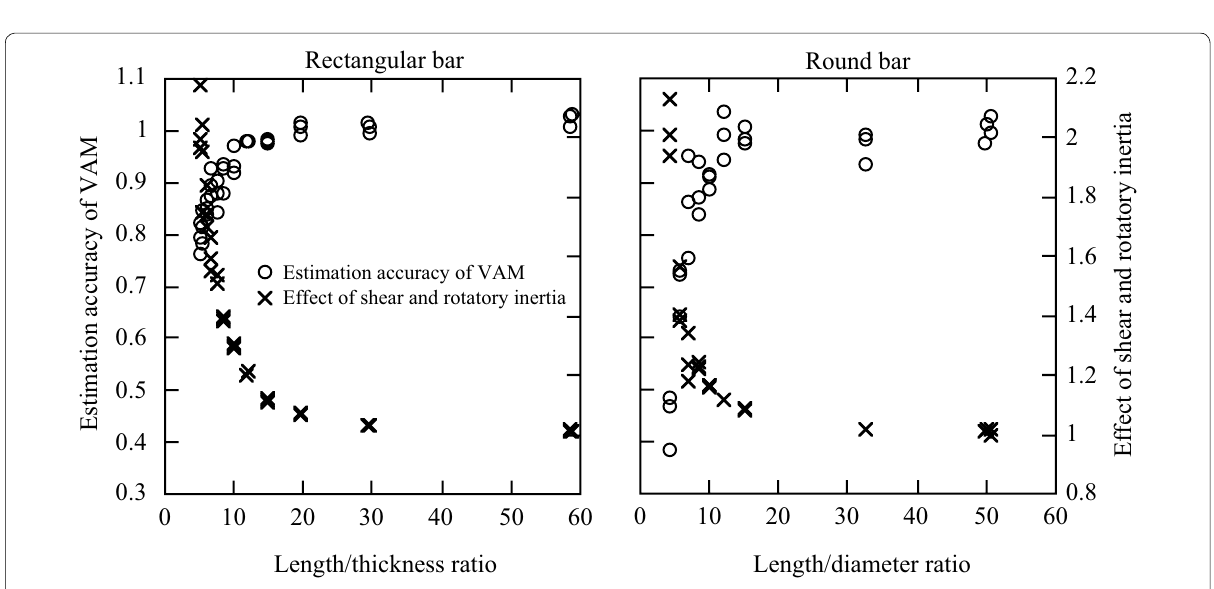
Fig. 3 Estimation accuracy of the VAM and the effect of deflections due to shear and rotatory inertia involved in the bending vibrational deflection (SR effect) at various length/thickness and length/diameter